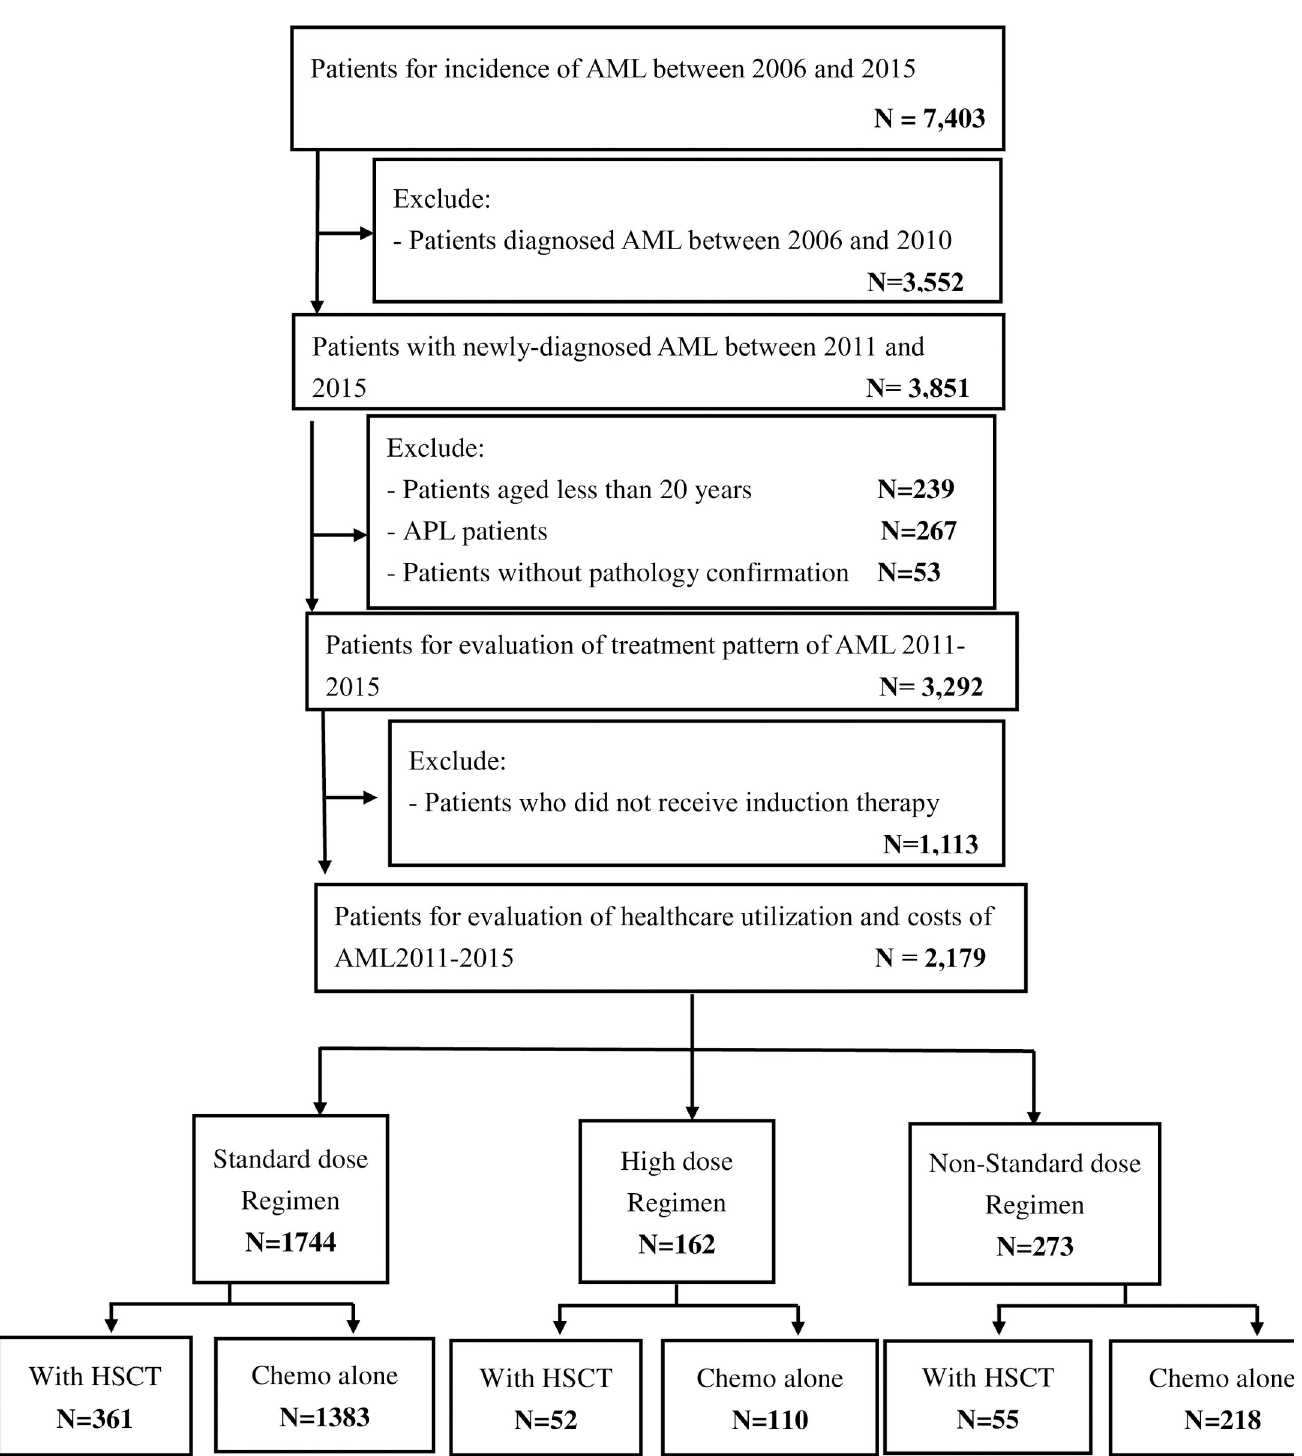
Fig 1. Flowchart of the study cohort selection. AML, acute myeloid leukaemia; APL, acute promyelocytic leukaemia; Chemo alone, chemotherapy alone; HSCT, hematopoietic stem cell transplantation.